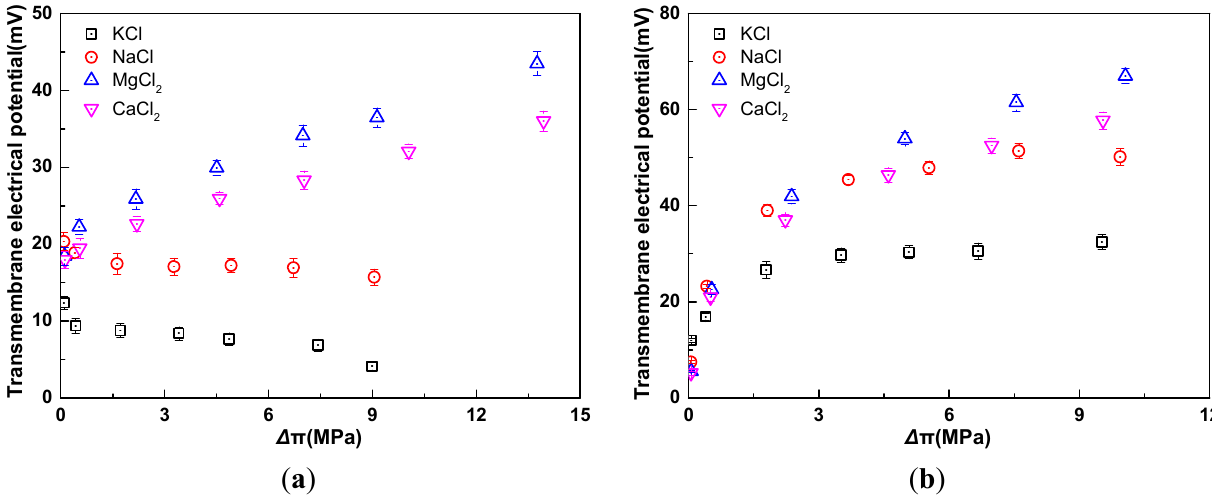
Figure 6. Relationship of transmembrane electrical potential and osmotic pressure difference for four draw solute in AL-DS mode ( t = 25 °C). ( a ) C The osmotic pressure difference refers to the effective values after correction for the effect of